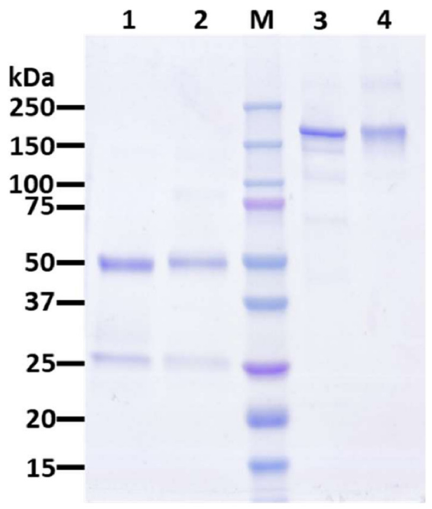
Figure 2. Purification of pIL6RmAb from N. benthamiana plants. Protein A affinity column-purified pIL6RmAb from leaves was analyzed on a 4–20% gradient SDS-PAGE gel under reducing (Lane 1) or non-reducing (Lane 3) conditions and visualized with Coomassie staining analysis. Lanes 1 and 3, Protein A-purified pIL6RmAb (2.5 µg); Lanes 2 and 4: human IgG as an isotype reference standard (2.5 µ g); M: protein molecular weight marker; One representative of several independent experiments is